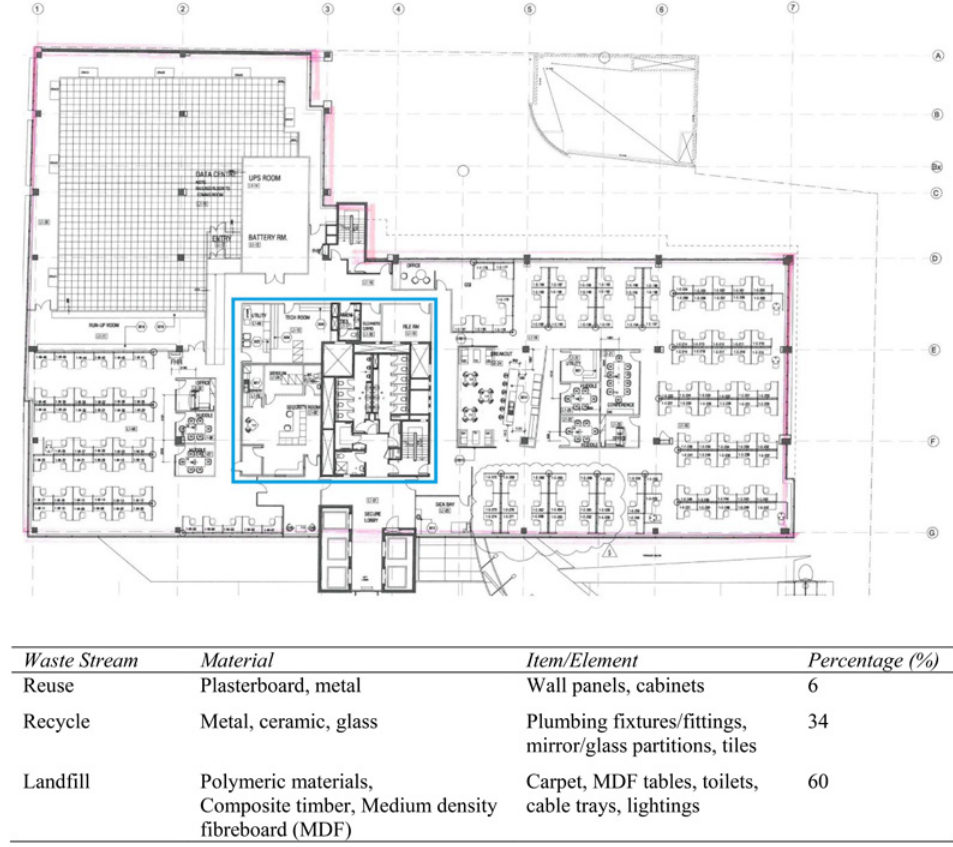
A quantitative analysis of reusability and recyclability of office fit-out